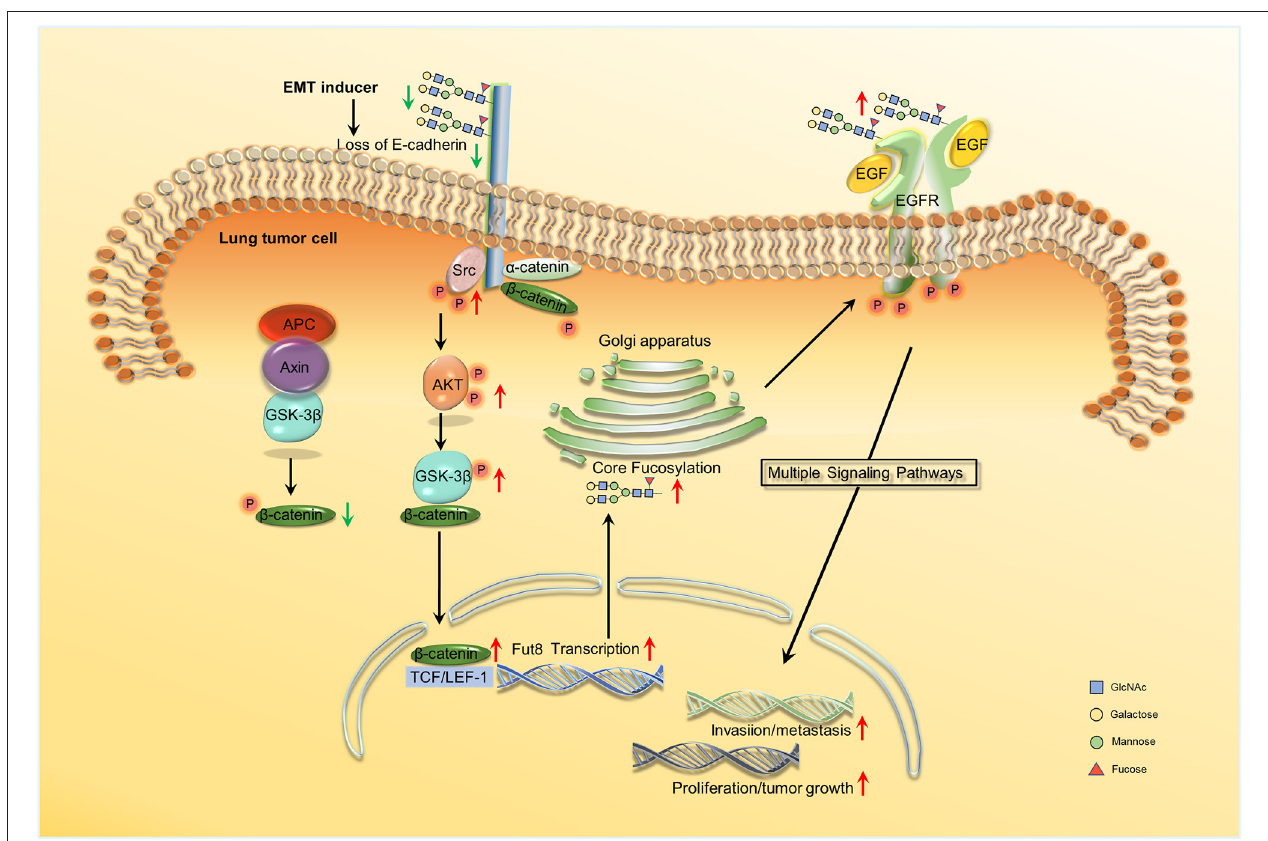
FIGURE 2 | Schema of core fucosylation regulation of lung cancer progression. A decreased level of core fucosylation of E-cadherin activates Src, which leads to the accumulation of nuclear β -catenin (83, 85). β -catenin can further combine with LEF1 and promote the transcription of Fut8. Besides, the upregulation of core fucosylation will result in the dimerization and phosphorylation of EGFR and ultimately activate the downstream signaling and the cascade reactions ( 19, 86). No permissions were required to use the